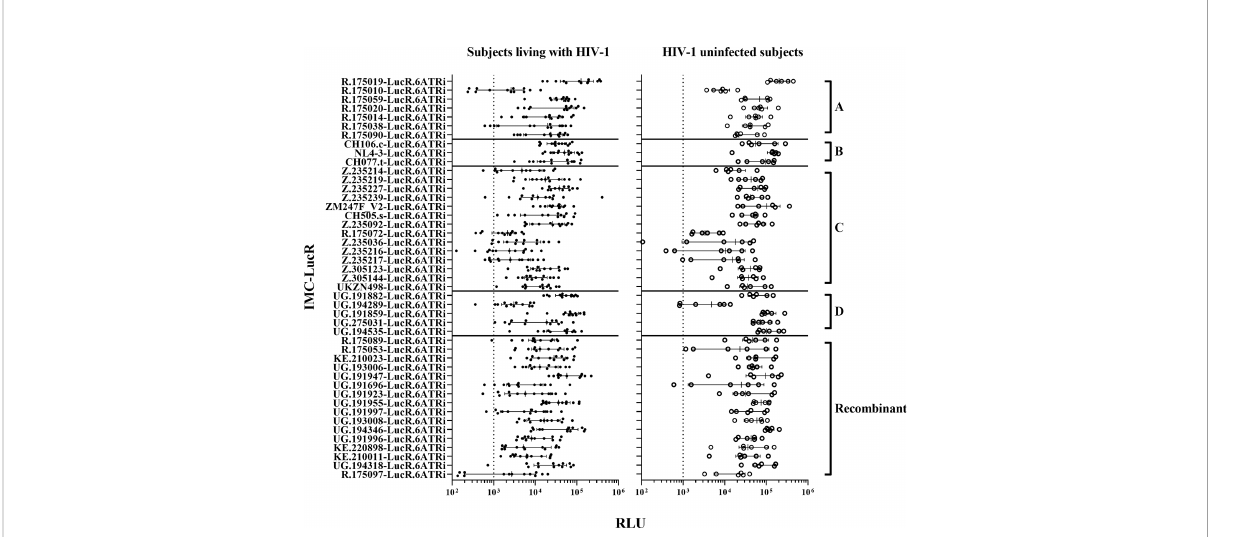
FIGURE 1 HIV-1 IMC-LucR replication in expanded CD4 T-cells. Replication in expanded CD4 T-cells from ART naive subjects living with HIV-1 (on the left panel), and HIV-1 uninfected subjects (on the right panel) arranged by IMC HIV-1 clade (A-D) and Recombinant). Replication is measured as RLU of CD4 T-cell cultures at 8 days post-infection. Each data point represents the mean RLU of duplicated values for each subject ’ s CD4 T-cells infected with a speci fi c HIV-1 IMC-LucR. Bars represent RLU median with interquartile range. The dotted line represents the assay optimal RLU